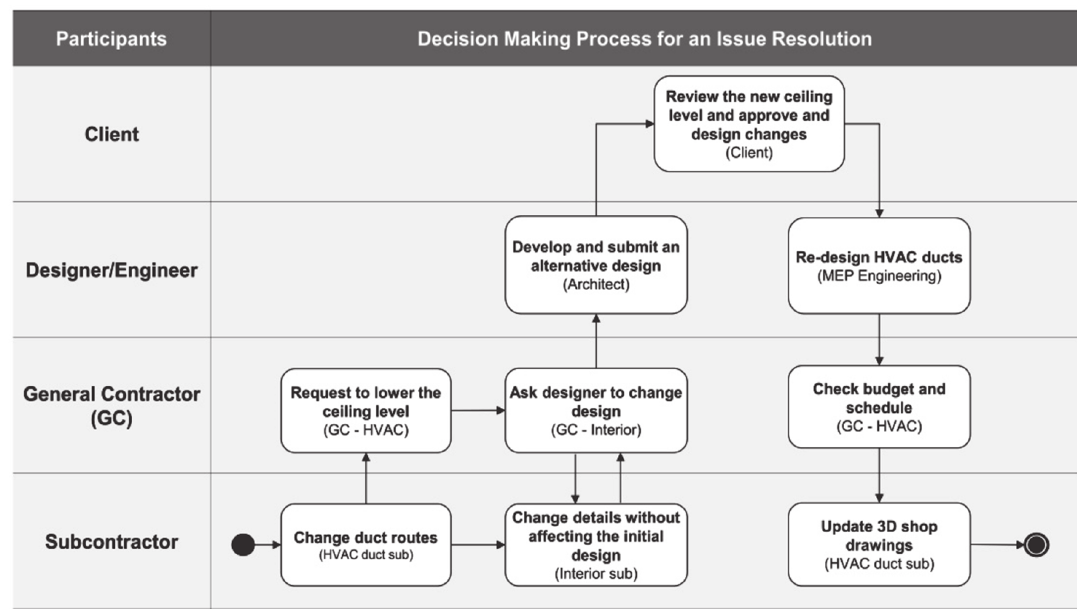
Figure 4. An example of issue-resolution process